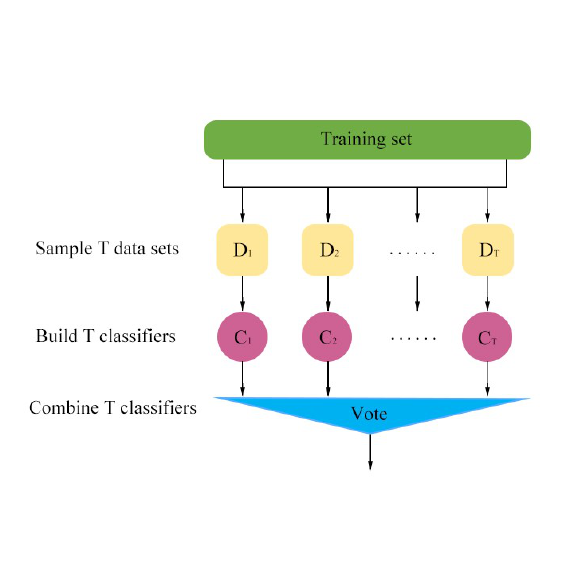
Fig. 3. Schematic diagram of Bagging